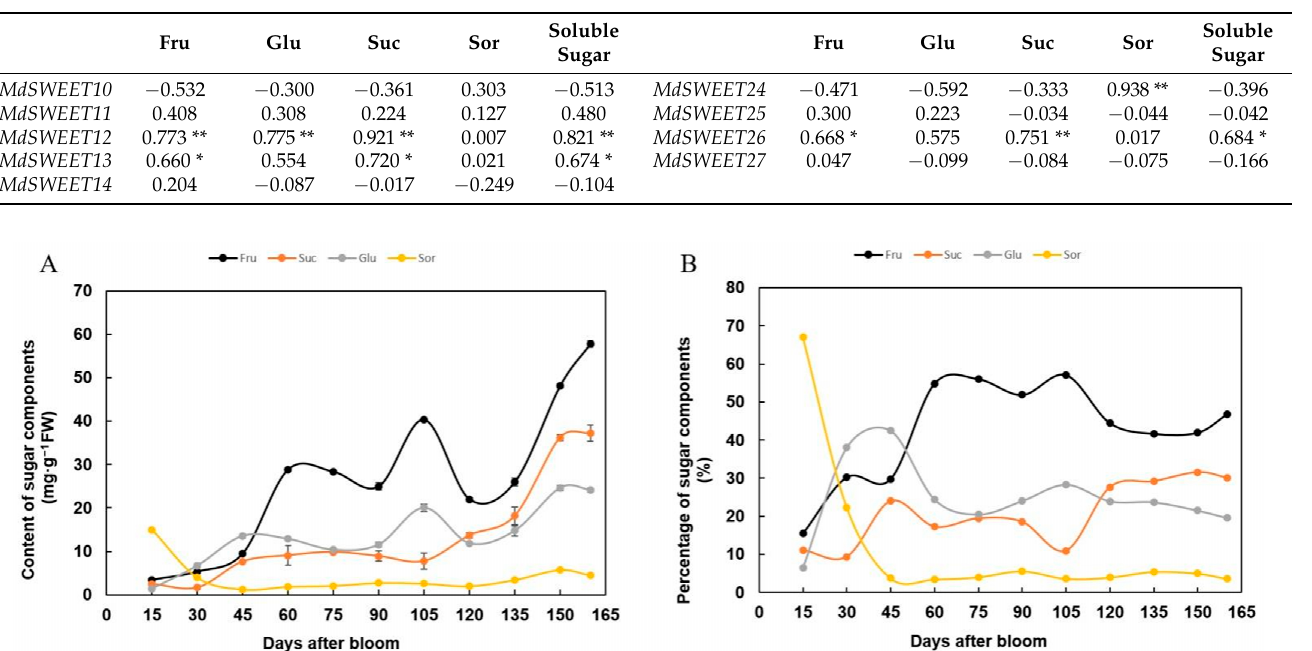
Figure 9. Analysis of the content and proportion of sugar components at different fruit development stages of the “Hanfu” apple. ( A ) Sugar contents in different fruit stages. Fructose (Fru), glucose (Glu), sucrose (Suc), and sorbitol (Sor) contents were determined by HPLC. Data represent the mean of three biological replicates. ( B ) Proportions of sugar components in different fruit stages. Error bars: standard deviation ( n = 3). Table 4. Correlation analysis of expression levels and main sugar or soluble sugar content during the fruit developmental period. Correlation analysis of the expression levels and main sugar or soluble sugar content during the fruit developmental period was performed using Duncan ′ s mul- tiple range test. Significant and highly significant differences are indicated by * p < 0.05 and ** p < 0.01, respectively.